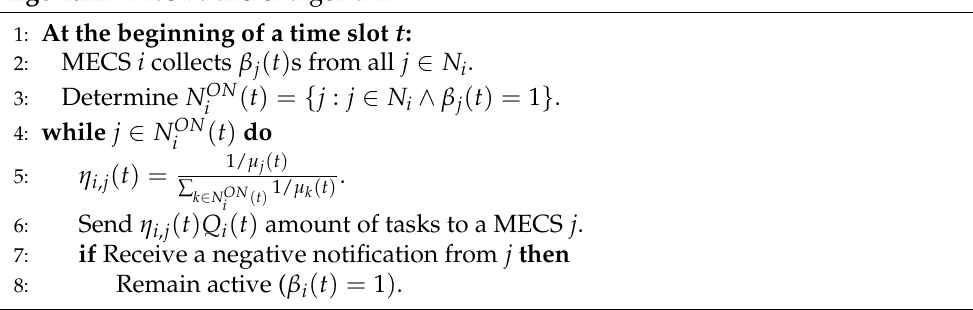
Algorithm 2 Task transfer